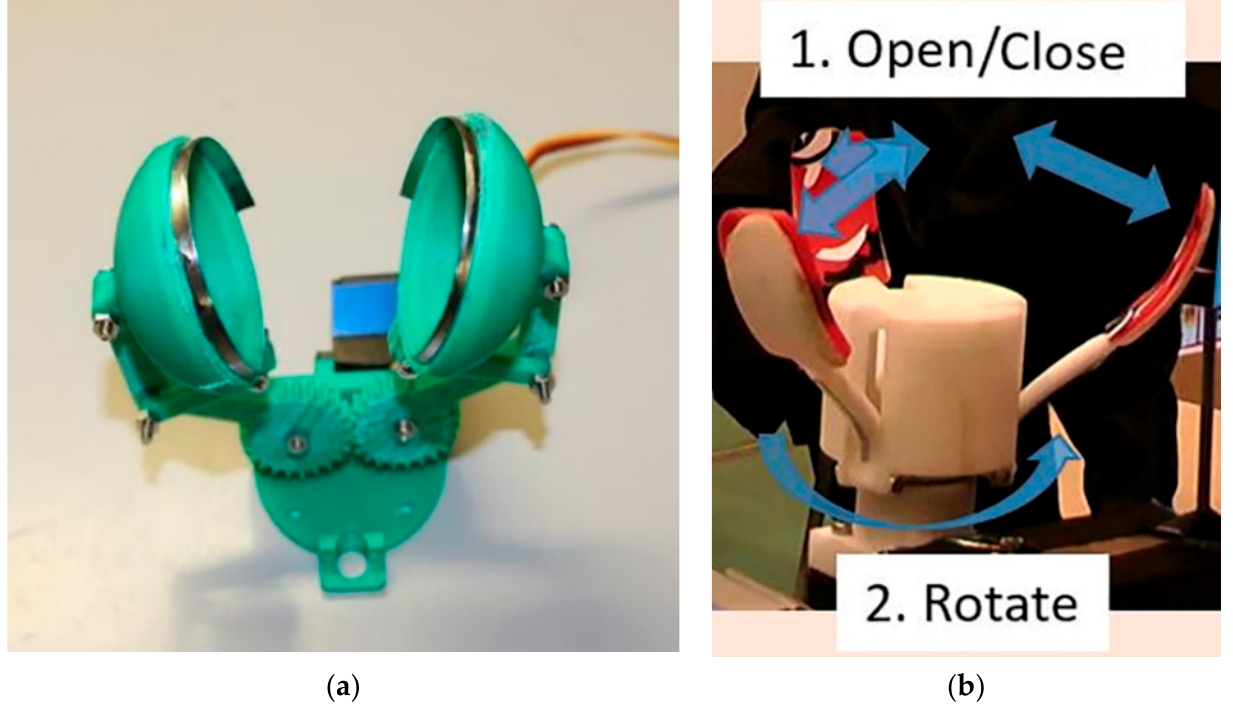
Figure 5. Tomato harvesting end effectors proposed ( a ) by Yeshmukhametov et al. (Reprinted/adapted with permission from Ref. [18]. 2022, Yeshmukhametov, A.) and ( b ) by Yaguchi et al. (Reprinted/adapted with permission from Ref. [55]. 2016, Yaguchi, H.).